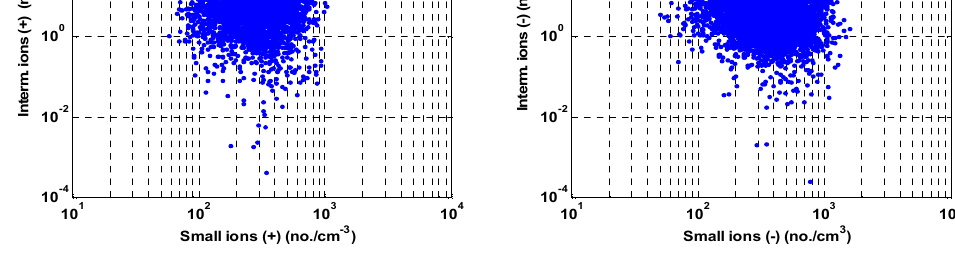
Figure A5. Correlation between intermediate ions and small ions.